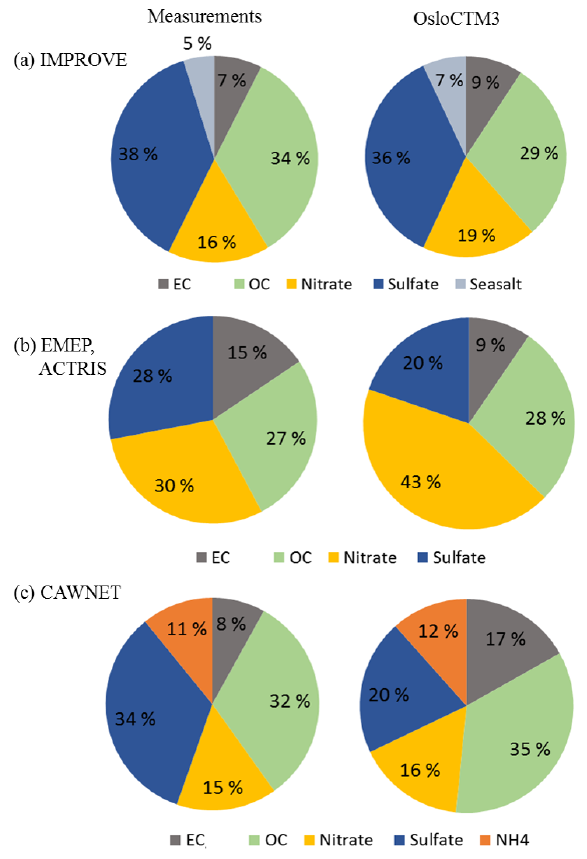
Figure 2. Aerosol composition (fraction of total aerosol mass) de- rived from the IMPROVE, EMEP–ACTRIS, and CAWNET net- works (left column) and corresponding Oslo CTM3 results (right